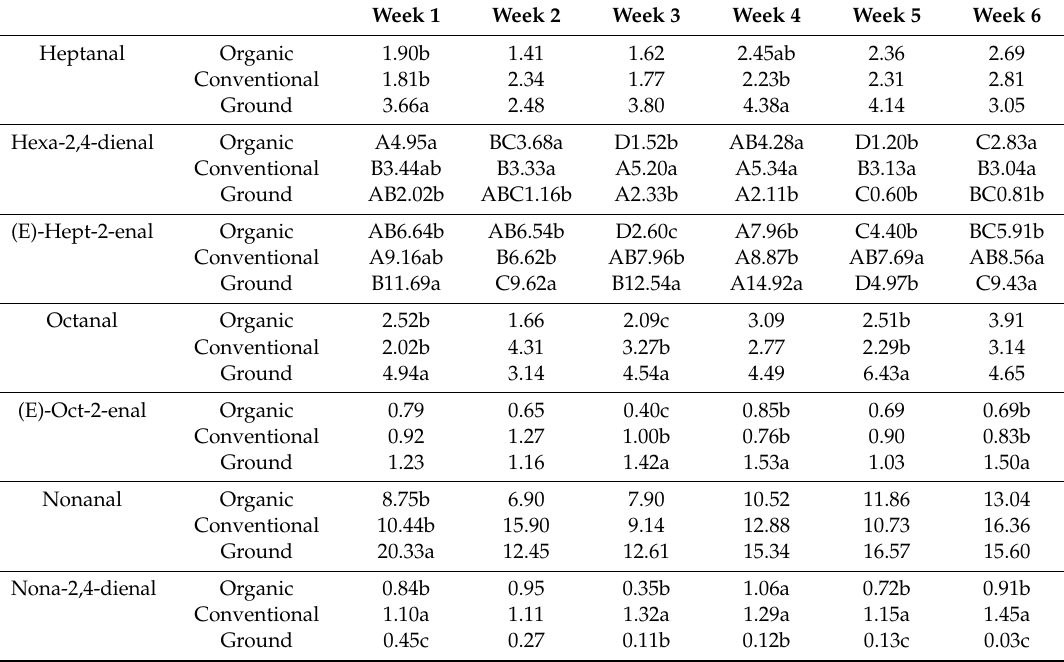
Table 5. Results (means and significance *) for the most representative oxidation compounds of the Verdial de Badajoz oil headspace significantly a ff ected by the organic production, harvesting method and / or harvesting time according to Table